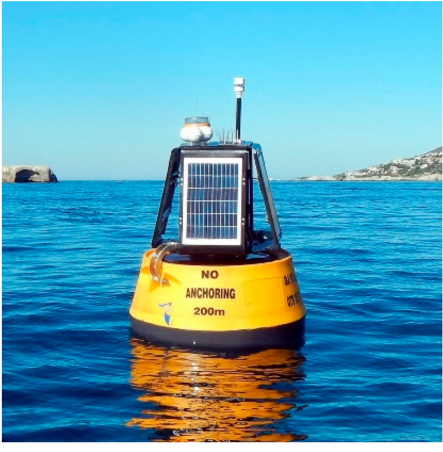
Figure 7. Smart buoy